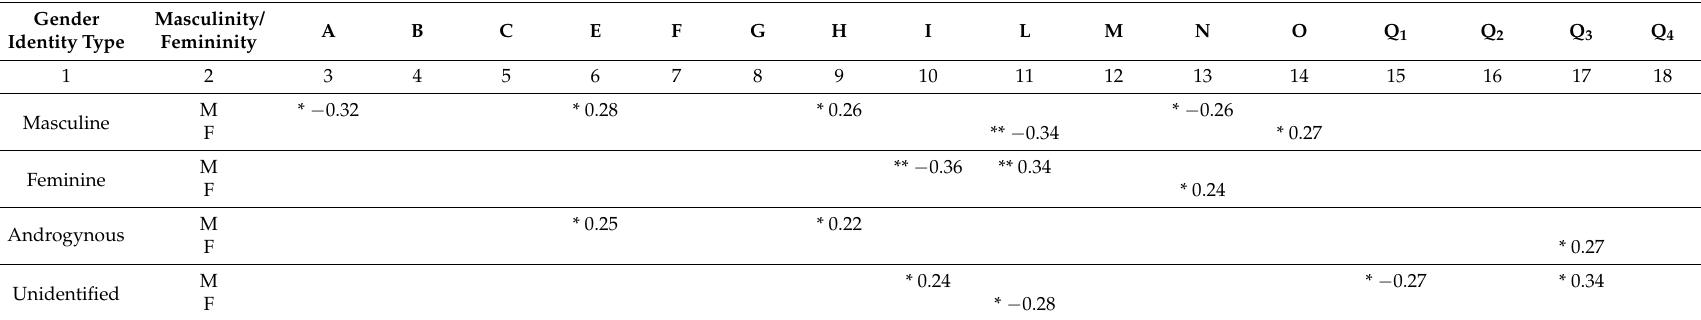
Table 3. Correlation dependencies of masculinity and femininity expressions with Raymond B. Cattell’s Sixteen Personality Factor Questionnaire among female